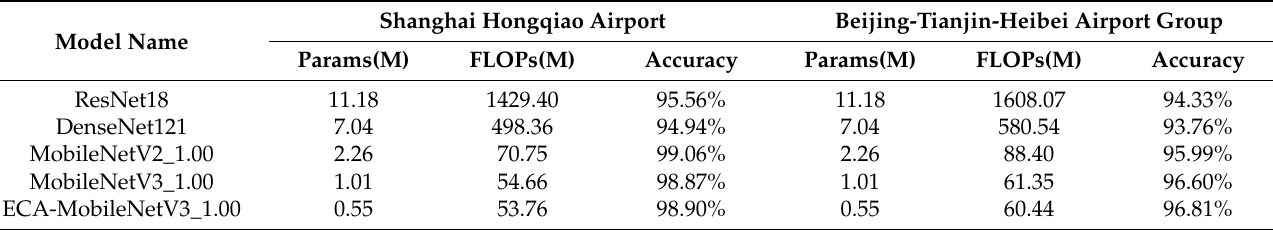
Table 8. Comparison of the evaluation indicators for the different